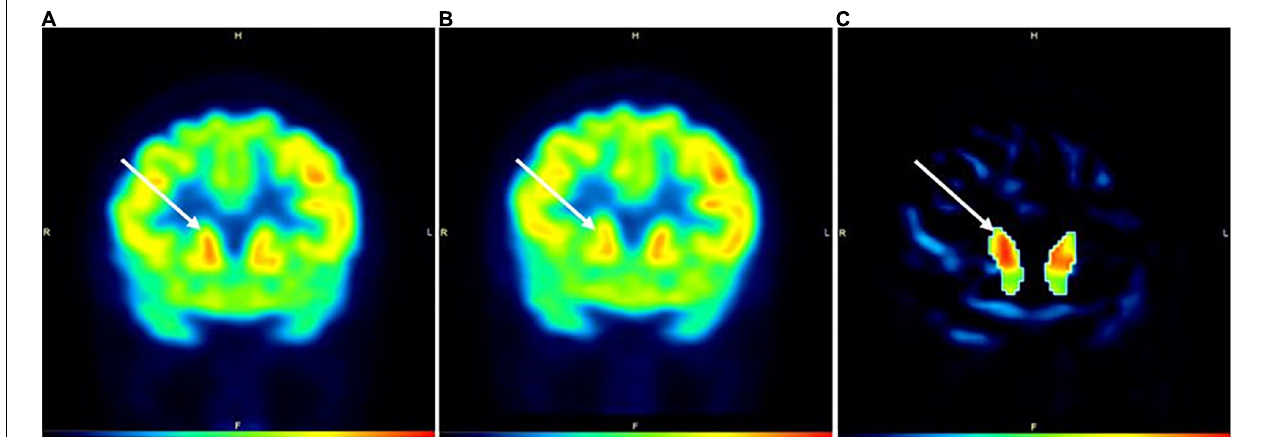
FIGURE 2 | PET images during active (A) and SHAM (B) conditions in Subject3. Image (C) represents a subtraction PET image with the globally normalized activity in sham subtracted from the globally normalized activity in active. All areas in image (C) are masked except for the caudate nuclei. White arrows denote the location of the caudate nuclei. The color bar indicates level of increased FDG uptake (black = no uptake; red = highest glucose uptake). H = head; F = foot; R = right; L = left.